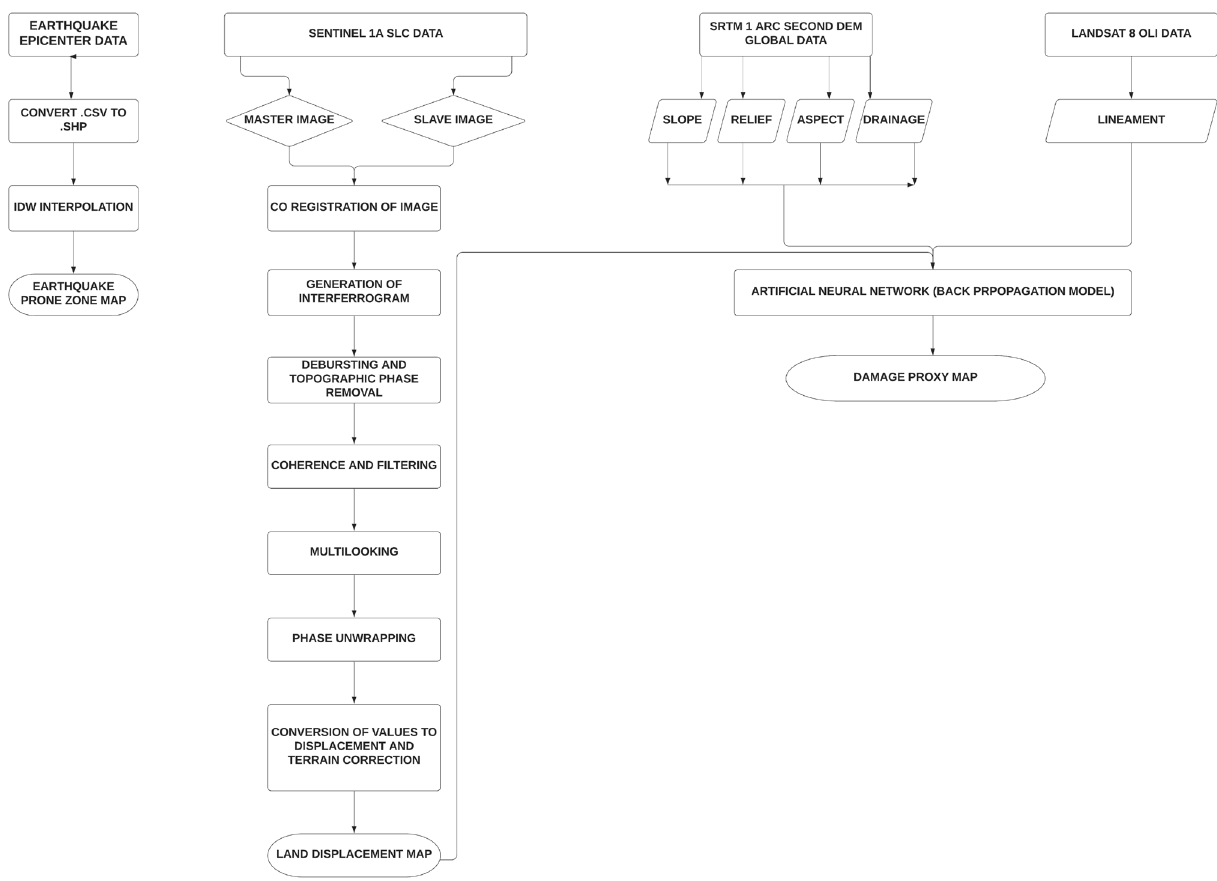
Fig. 3 Flow chart of methodology adopted in this